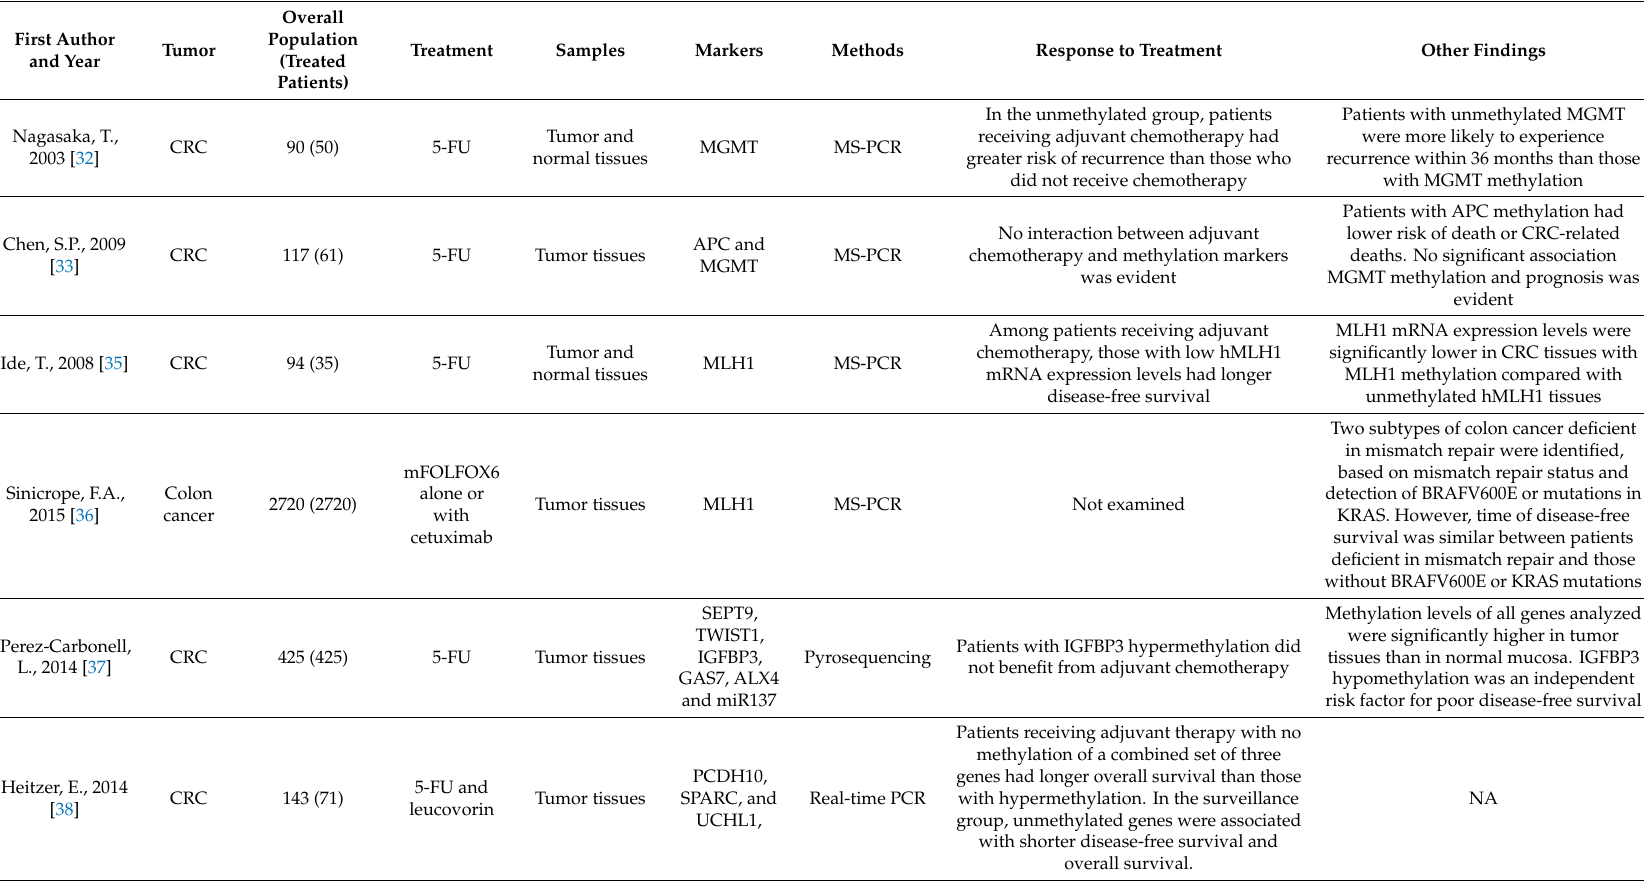
Table 1. Gene-specific methylation markers in patients receiving adjuvant